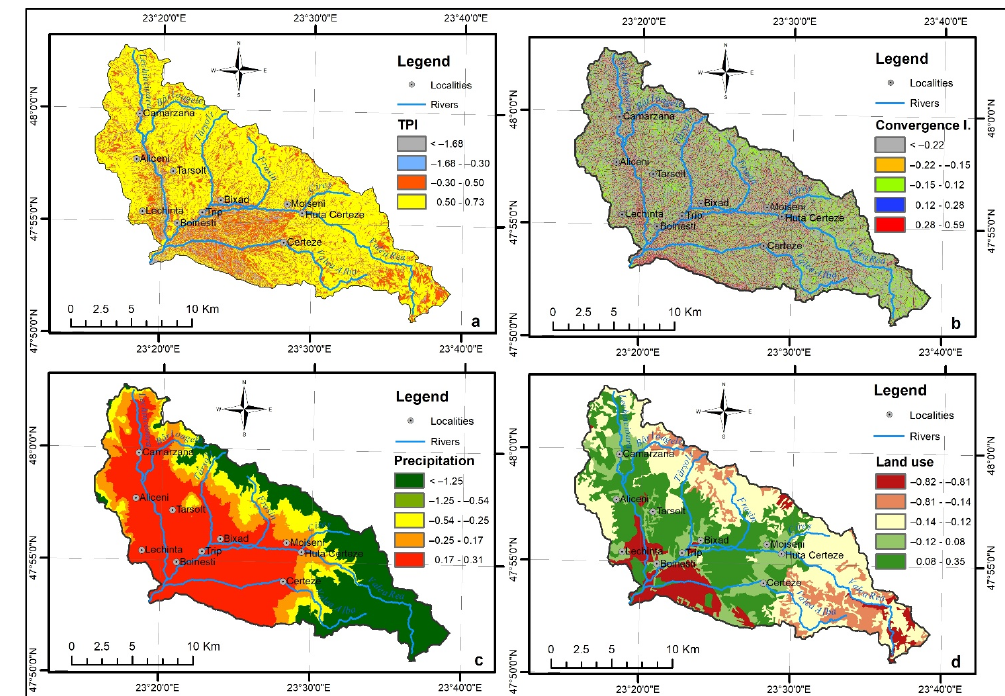
Figure 5. ( a ) Topographic Position Index, ( b ) Convergence Index, ( c) Precipitation, ( d ) Land use. Table 2. Flash flood predictor variables classes with their WofE